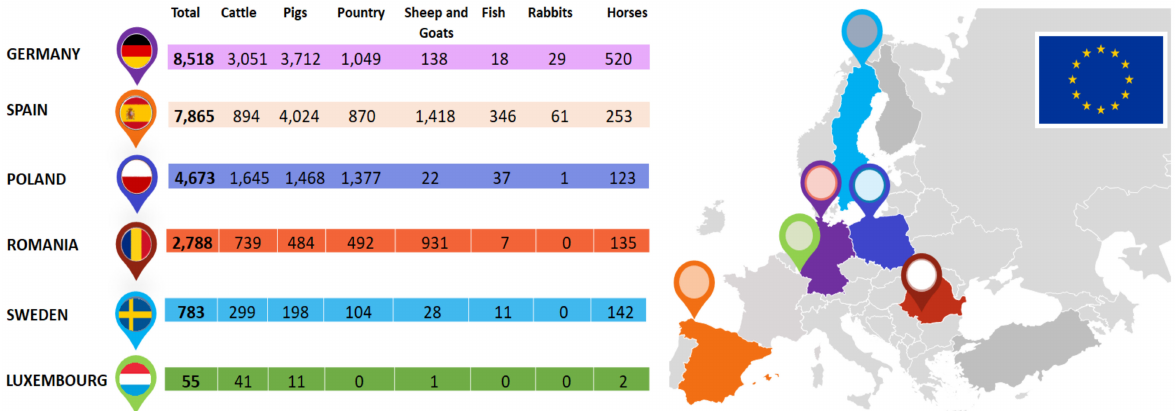
Figure 1. Estimated PCU (in 1000 tonnes) of the population of food-producing species (including horses) for 2018 in some EU member states according to the European database of sales of veterinary antimicrobial